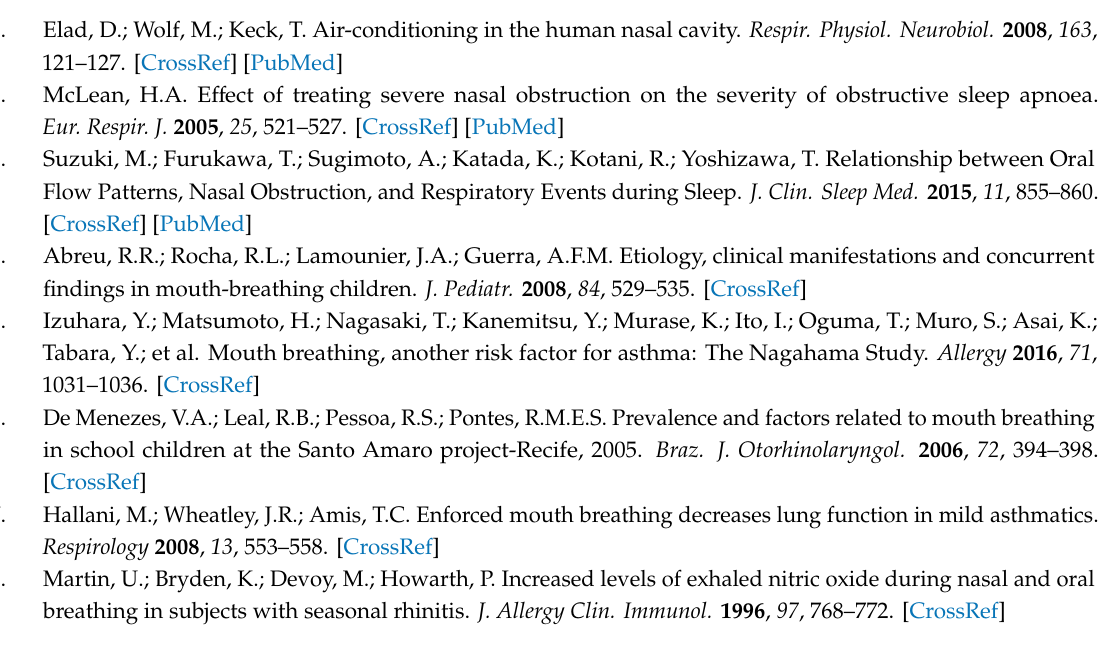
Table S1: 164ROIs used as functional connectivity analysis, Table S2: Statistical result for mean and variance of GSs of mouth and nose breathings, Figure S1: Mean time-course signals presented with Z–scores of GS. Blue legend represented “Nose” breathing condition and red legend represent “Mouth” breathing